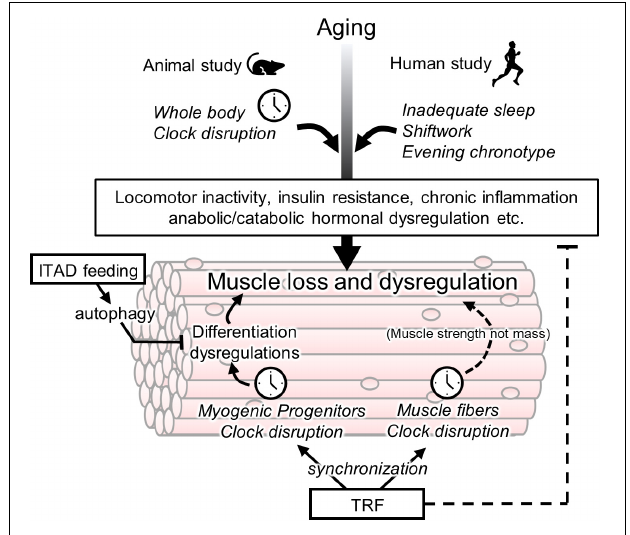
FIGURE 1 | Association between circadian clock and age-related muscle loss and targets of chrono-nutrition. Age-related muscle loss is accelerated by a disturbance of a circadian clock in the animal and human studies. Its disturbance may be involved in early onset of sarcopenia via several non-muscular rhythmic functions such as a locomotor activity and insulin resistance. The muscle fiber clock has a impact on the age-related weakness of muscle strength. The circadian clock in myogenic progenitors controls muscle differentiation however its involvement in sarcopenia is unclear yet. The isocaloric twice-a-day (ITAD) feeding promotes the myogenesis via the activation of autophagy in myogenic progenitor cells. The time-restricted feeding (TRF) may have a potential for prevention of age-related muscle dysfunctions via entrainment of the peripheral clock including muscle fiber and progenitor cells. In addition to the role of TRF as an entrainer, TRF also maintains the daily homeostasis of metabolism such as prevention of insulin